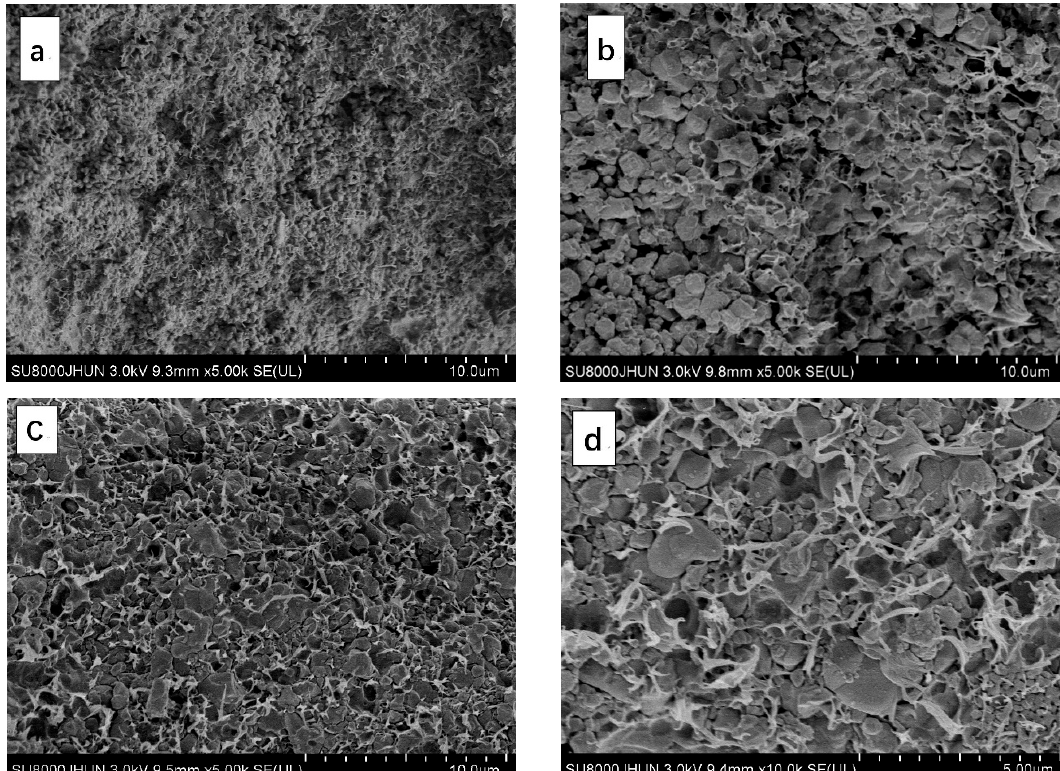
Figure 2. SEM micrographs of the fracture cross ‐ section of the composites: ( a ) f Al Al 2 O 3 /PP composite; ( b ) f BT : f PP = 50:50 BT/PP composite; ( c , d ) f Al composite in different magnifications.